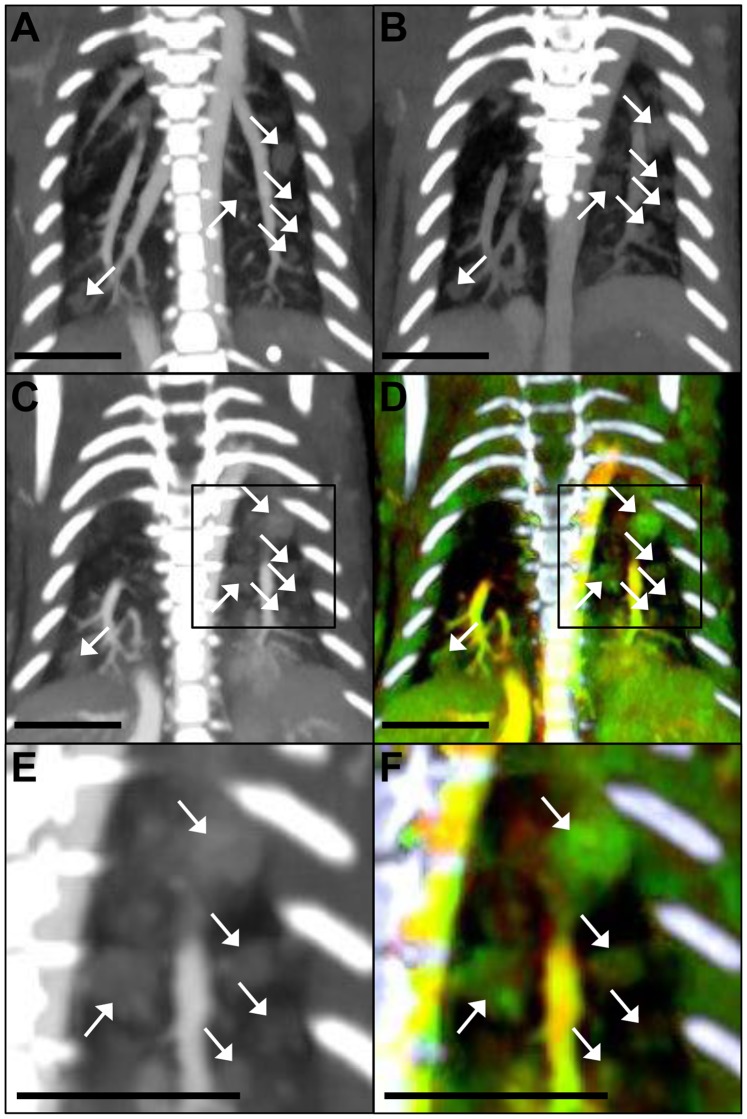
Thick slab maximum intensity projections of the lungs.Coronal CT images showing the filtered 80 kVp dataset from CT scan 1 (A), CT scan 2 (B), CT scan 3 (C), and the final overlay of the DE decomposition of CT scan 3 (D) with bones segmented out (bones in white). (E) is a zoomed-in image of the right side of CT scan 3, and (F) is a zoomed in image of the right side of the DE overlay of CT scan 3. The boxes in (C) and (D) show the regions that are enlarged in (E) and (F), respectively. 80 kVp images are windowed from –300 to 1200 HU. The overlays are windowed from 0.25 to 6 mg/mL gold, and 0.25 to 15 mg/mL iodine. The scale bar represents 0.5 cm in all images.